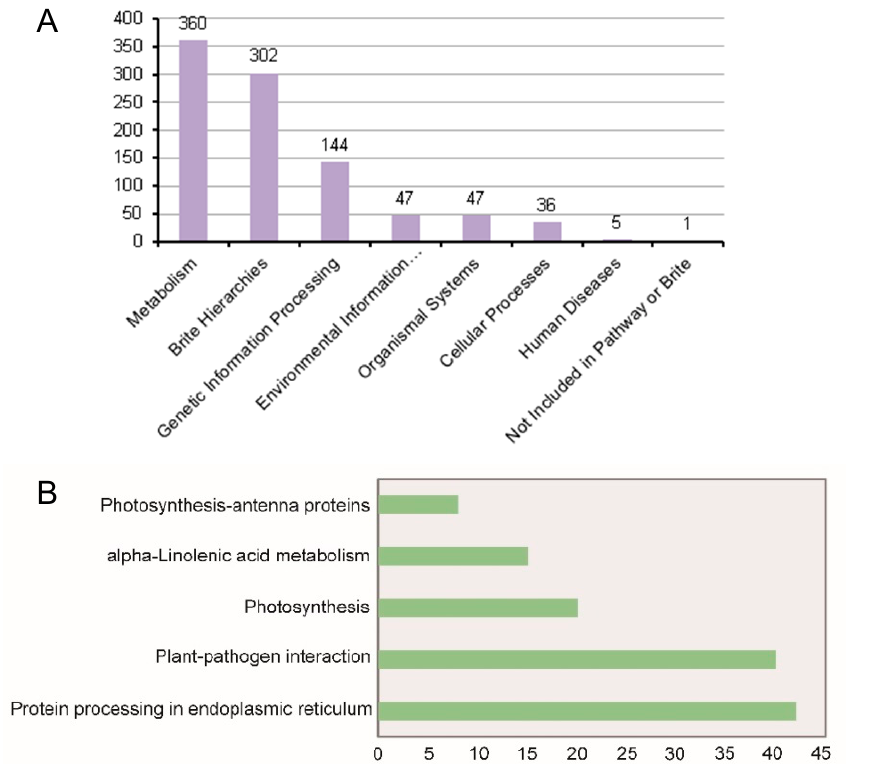
Figure 4. ( A ) KEGG pathway assignments into eight functional categories. ( B ) The signi fi cant en- richment list of KEGG pathways in subcategories. The signi fi cantly enriched pathway ( p < 0.05) and the number of enriched transcripts in each pathway are shown. The x-axis in Figure B indicates the number of di ff erentially expressed genes of these terms that are signi fi cantly enriched.